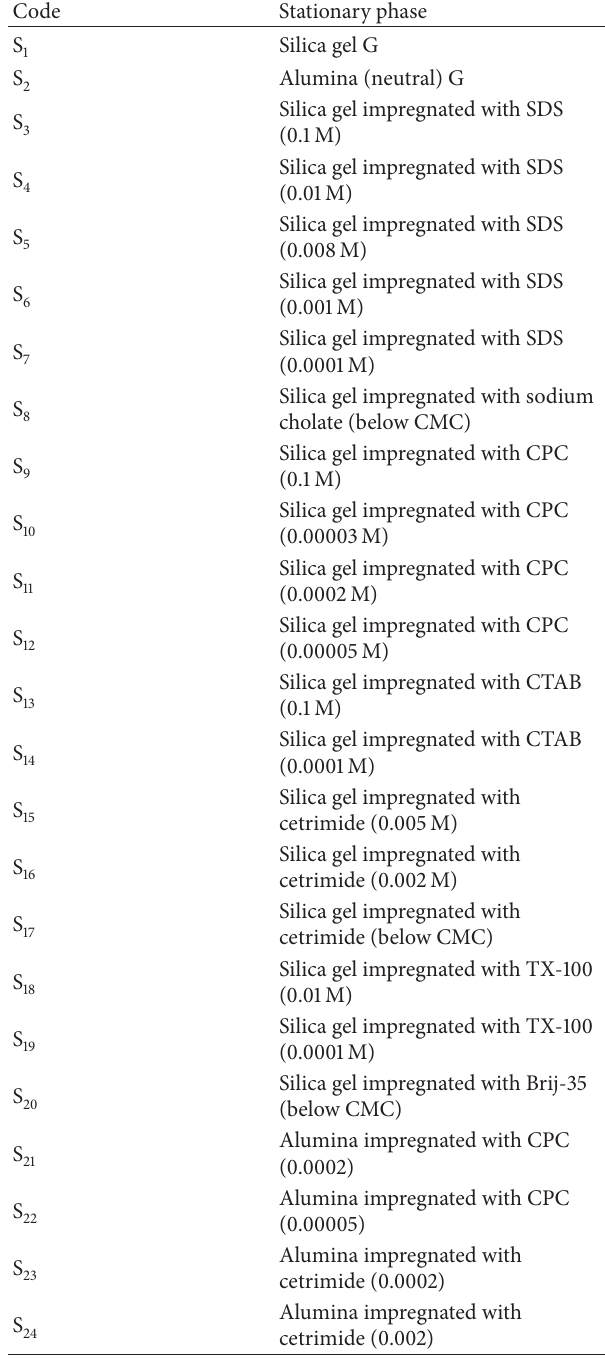
Table 1: Stationary